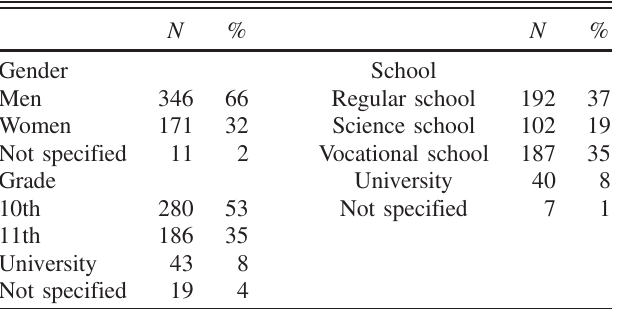
TABLE I. Number of Turkish high school and university students who were administered the AAPS survey by gender, grade level, and school